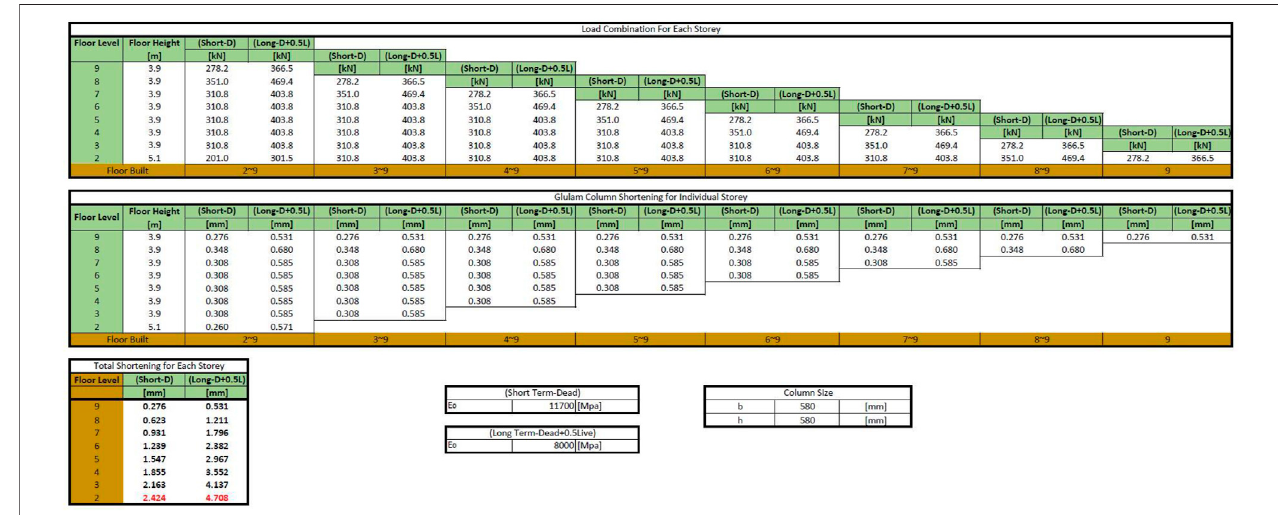
FIGURE 9 | Shortening of the glulam column.